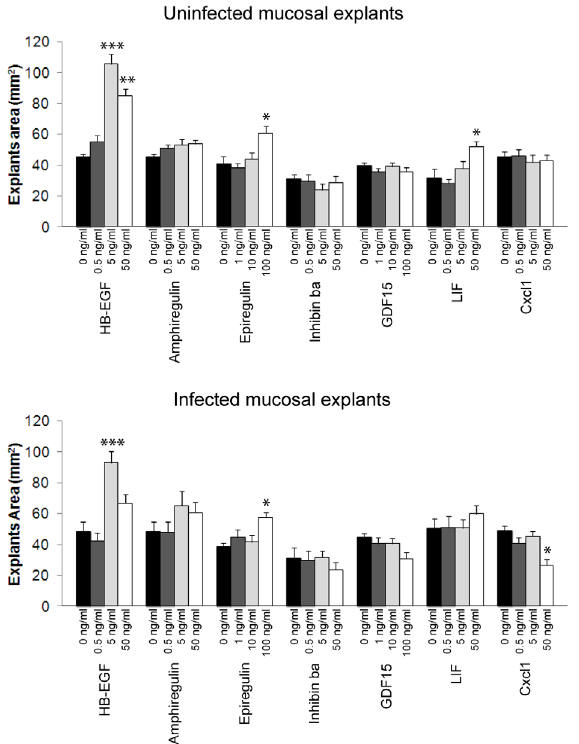
Figure 2. Invitro growth of ME mucosal explants treated with seven different growth factors identified by gene array analysis for their potential role in hyperplasia during acute OM. Each factor was tested on control (uninfected) mucosa as well as tissue from rats inoculated with NTHi. The graph represents the means of area 6 standard errors (SE) of each experimental group on the 10 th and final day of culture. (n=12 at each group). For this and subsequent figures, *=p , .05, **=p , .01, ***=p ,